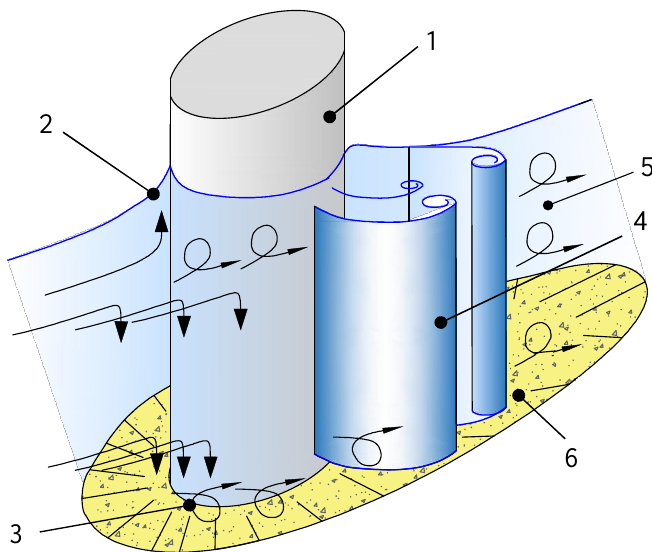
Figure 1. Flow pattern and local scour around a cylindrical pier schematic: 1—pier, 2—frontal wave, 3—horseshoe vortex, 4—lee-wake vortex, 5—farwater vortex, 6—local scouring area.